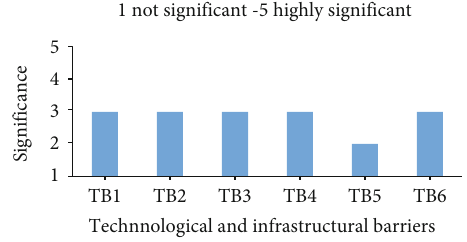
Figure 4: Signi fi cance of the technological and infrastructural barriers to the promotion of RE. TB1: grid connection constraints and lack of grid capacity; TB2: inadequate infrastructure to accommodate renewables; TB3: long processing time for the large number of permits; TB4: lack of regulatory framework for land securement; TB5: high risk of land speculation due to mining concessions; TB6: lack of coordination among relevant